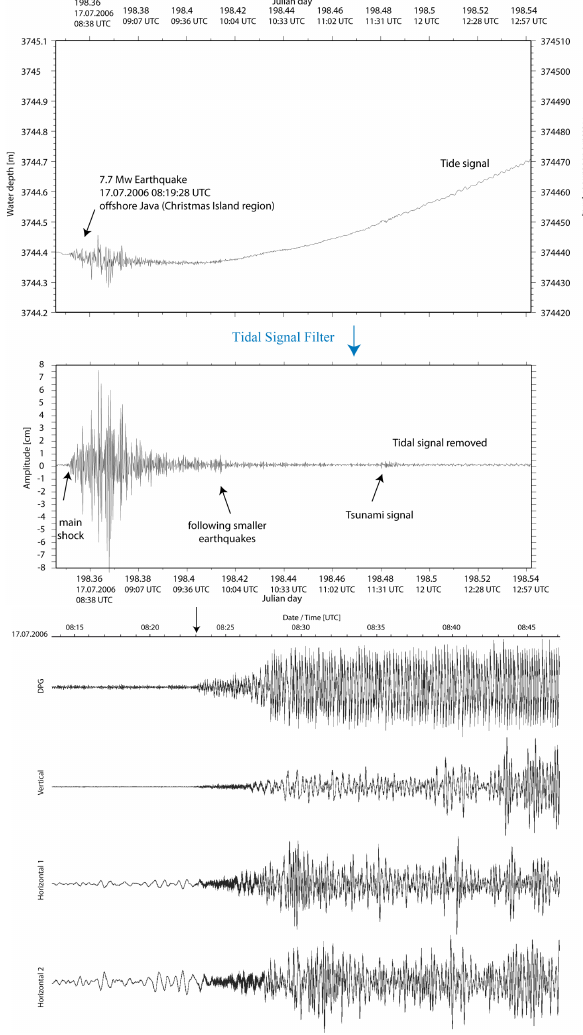
Fig. 22. Absolute pressure (top two), differential pressure gauge (DPG) and seismic (bottom four) data recorded by OBU-01-B lo- cated at 0 ◦ 25.515 0 S/96 ◦ 51.658 0 E near mooring GITEWS-1 near Sumatra at 0 ◦ 25.515 0 S/96 ◦ 51.658 0 E, depicting the 17 July 2006 Mw=7.7 earthquake. Data are high-pass frequency filtered. Arrow marks onset of P-wave